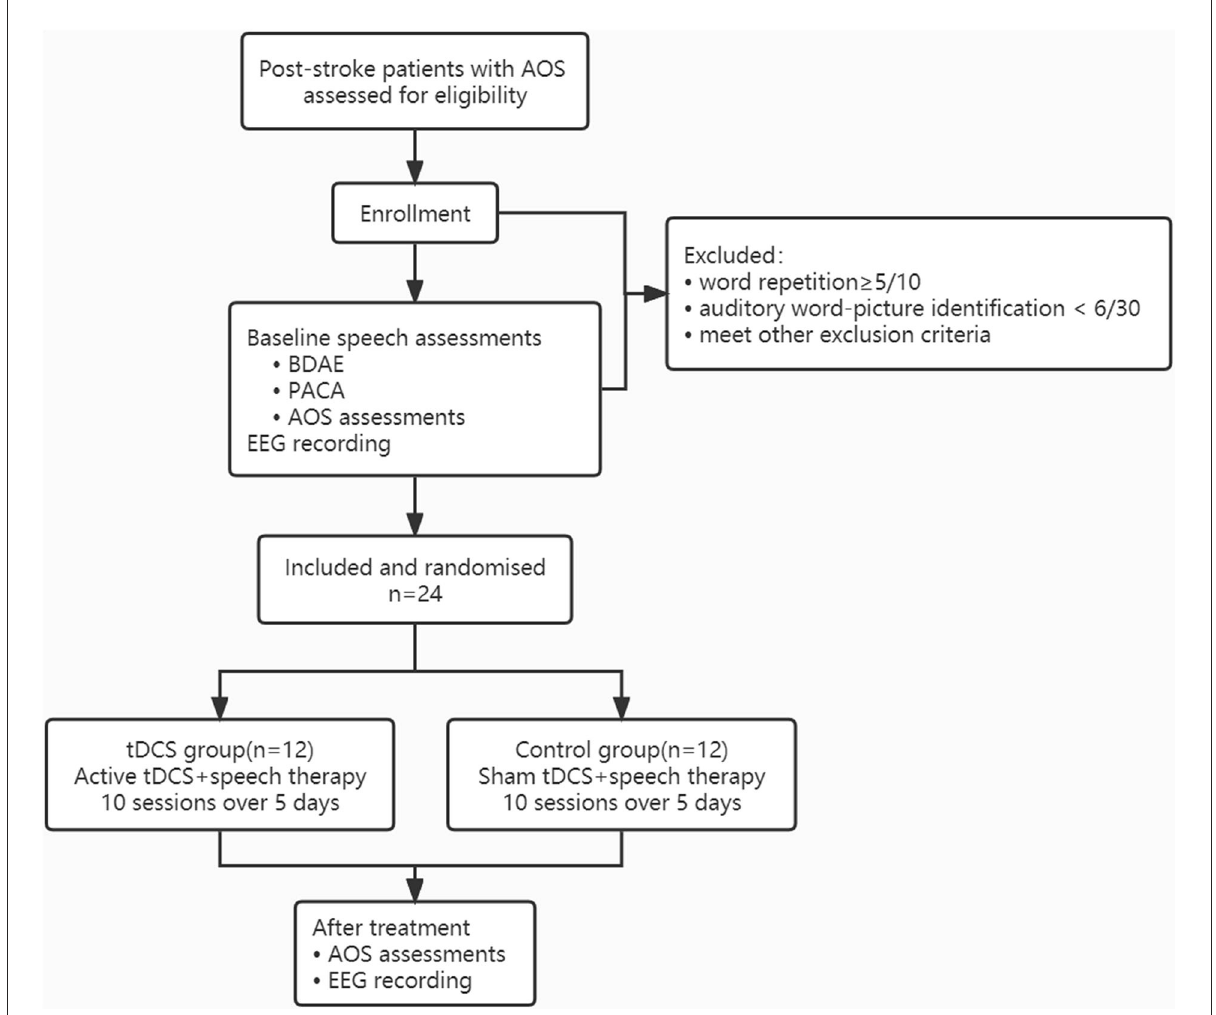
FIGURE2 The flowchart of this study. AOS, Apraxia of speech; BDAE, Boston Diagnostic Aphasia Examination-Chinese Version; PACA, Psycholinguistic Assessment in Chinese Aphasia; tDCS, transcranial direct current stimulation; EEG,